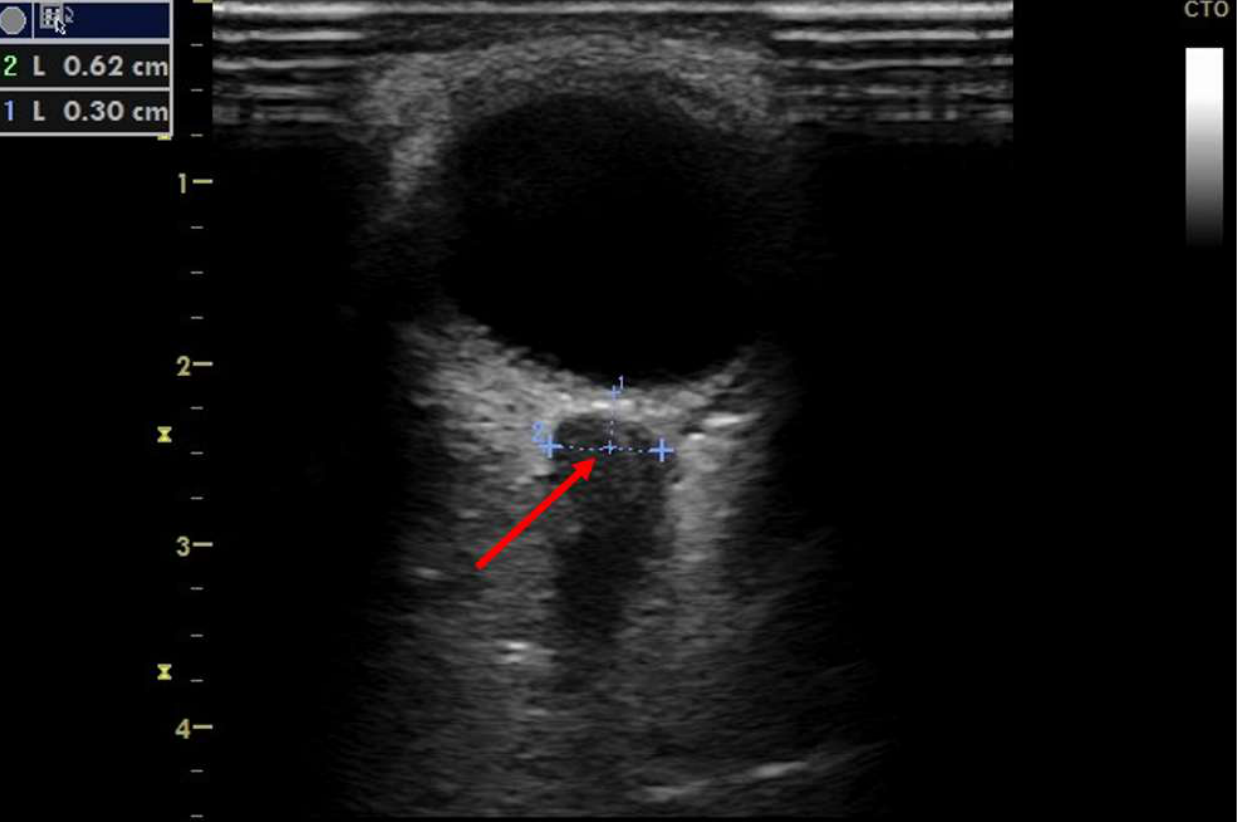
Figure 1. Ocular ultrasound in patient #1. Ocular ultrasound image. Optic nerve sheath diameter is measured 3 mm behind the globe at 6.2 mm (red arrow), indicating intracranial pressure above 20 mmHg.